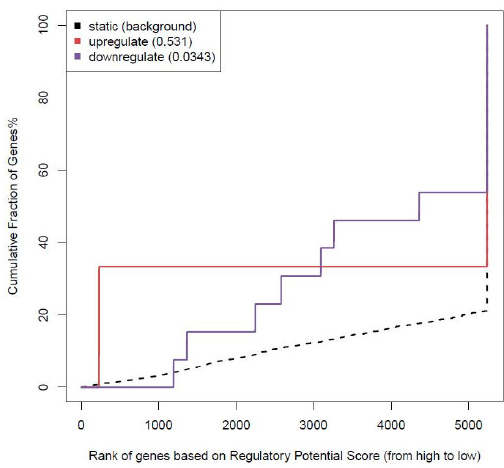
Figure 5. BETA activating and repressive function prediction of butyrate differentially CTCF-binding sites. The red line represents the upregulated genes, the purple line represents the downregulated genes, and the dashed line represents background genes with no differentially expressed genes. The p -values (inside the box) represent the significance of the difference between the up/down groups compared with the background genes by the Kolmogorov–Smirnov